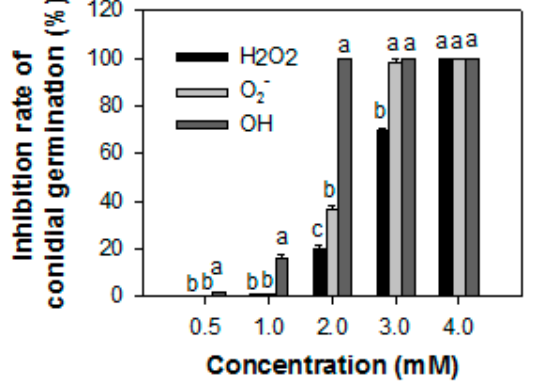
Figure 1. The inhibitory effect (%) of reactive oxygen species on the conidial germination of Colletotrichum gloeosporioides from papaya fruit. The data were expressed as the means ± SE of three biological replicates. Different letters in the same column indicate significant differences.